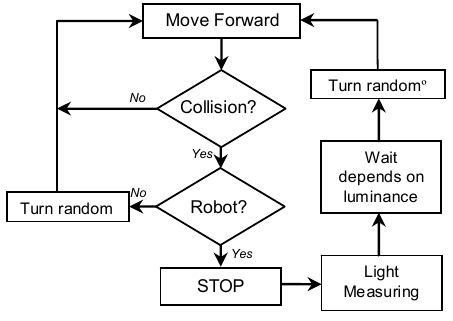
Fig. 2. Algorithm of honeybee aggregation